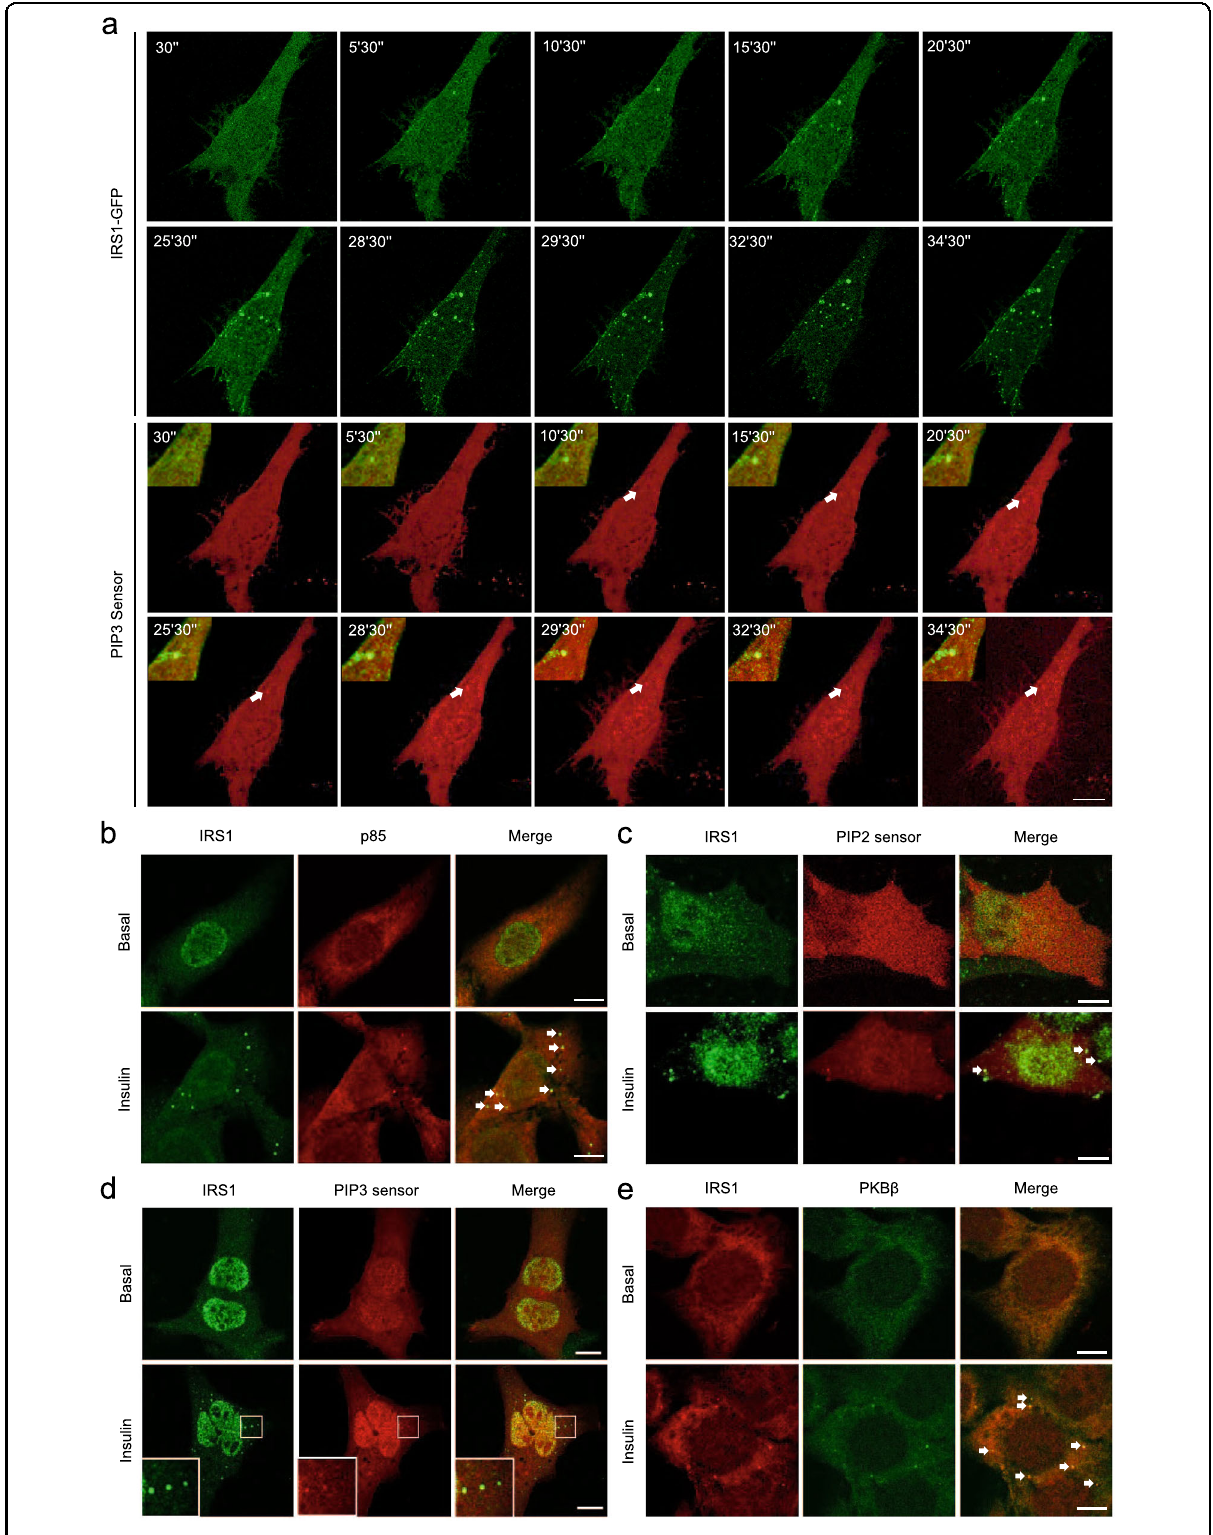
Fig. 6 (See legend on next